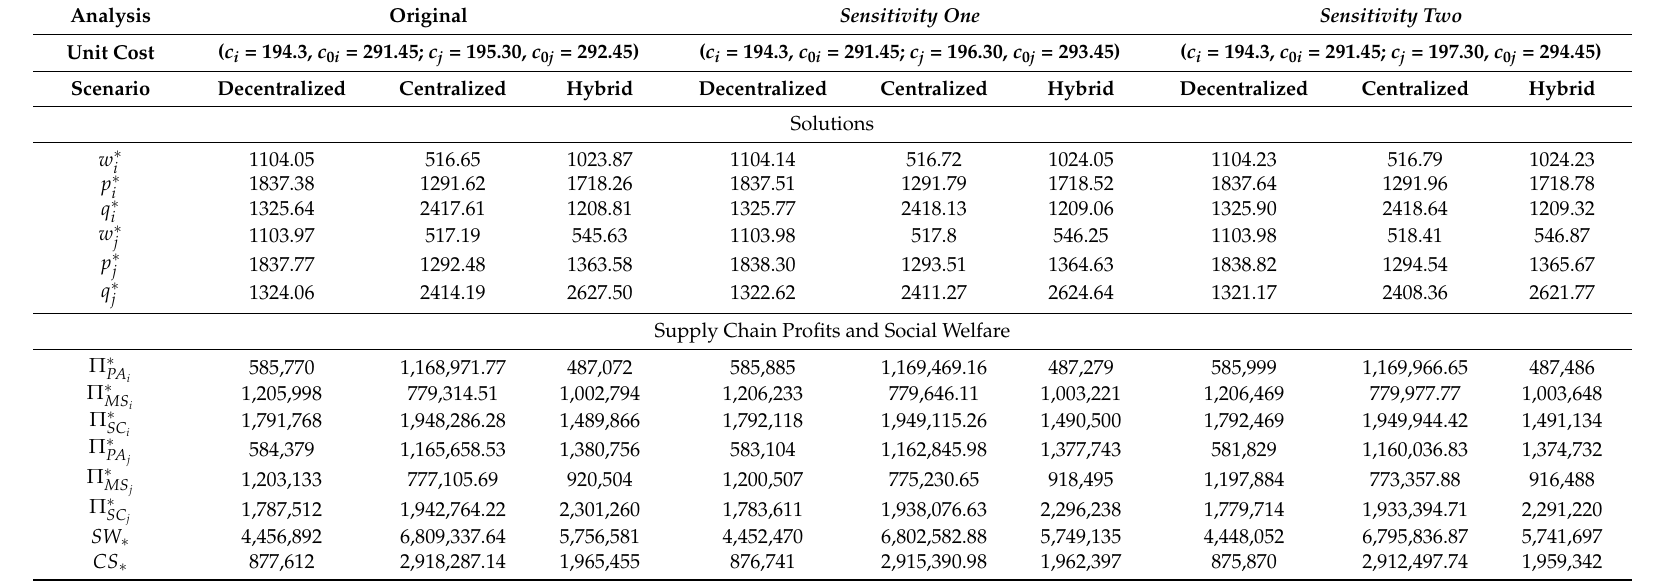
Table 3. Numerical and sensitive analysis results of dual competing PV supply chains without the government’s